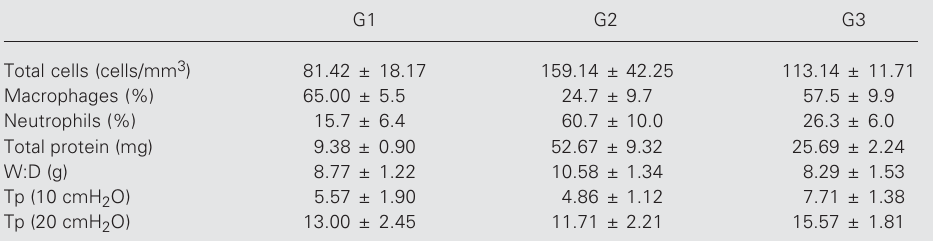
Data are reported as mean ± SD for 7 animals in each group. Infusion rate of pentoxifylline and normal saline: 50 mg kg -1 h -1 . Total cell count = G1 vs G2 (P < 0.001) and G2 vs G3 (P < 0.05). Macrophages = G1 vs G2 (P < 0.001) and G2 vs G3 (P < 0.001). Neutrophils = G1 vs G2 (P < 0.001) and G2 vs G3 (P < 0.001). Total protein = G1 vs G2 (P < 0.001), G1 vs G3 (P < 0.001) and G2 vs G3 (P < 0.001). W:D = G2 vs G3 (P < 0.0143).